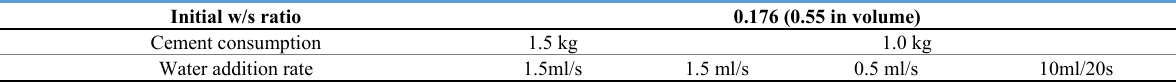
Table 4. Adapted mixing energy test procedure